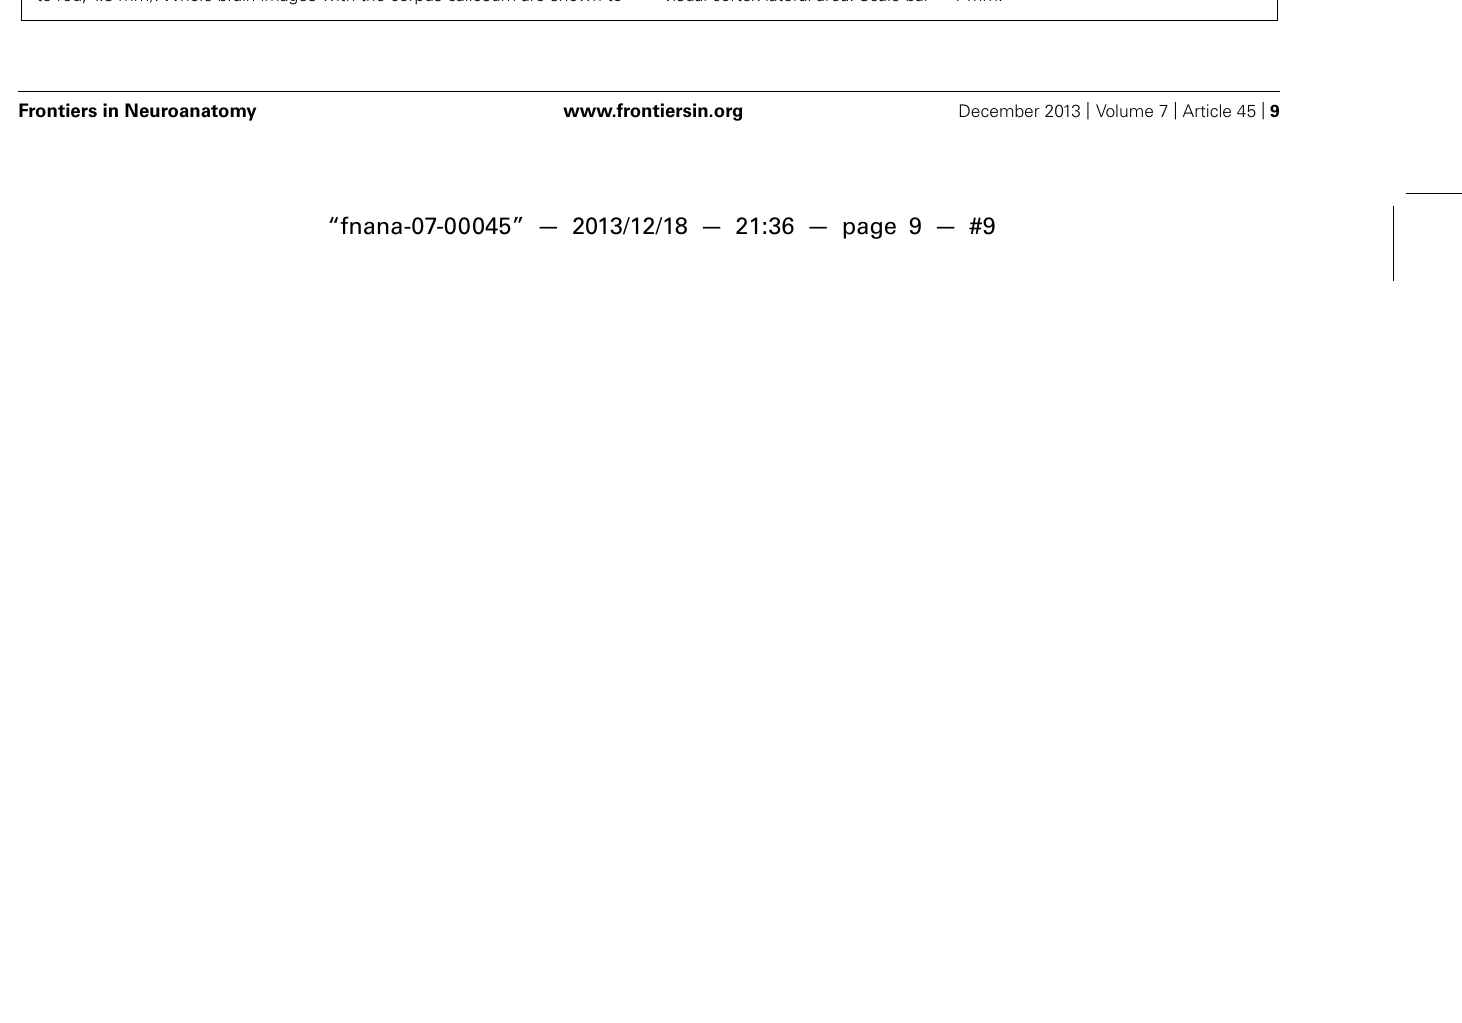
the right. Colors reveal the directions of the tracts (red, right–left; green, cranial–caudal; blue, ventral–dorsal). M1, primary motor cortex; S1, primary somatosensory cortex; S2, secondary somatosensory cortex;V1, primary visual cortex;V2M, secondary visual cortex medial area;V2L, secondary visual cortex lateral area. Scale bar = 1